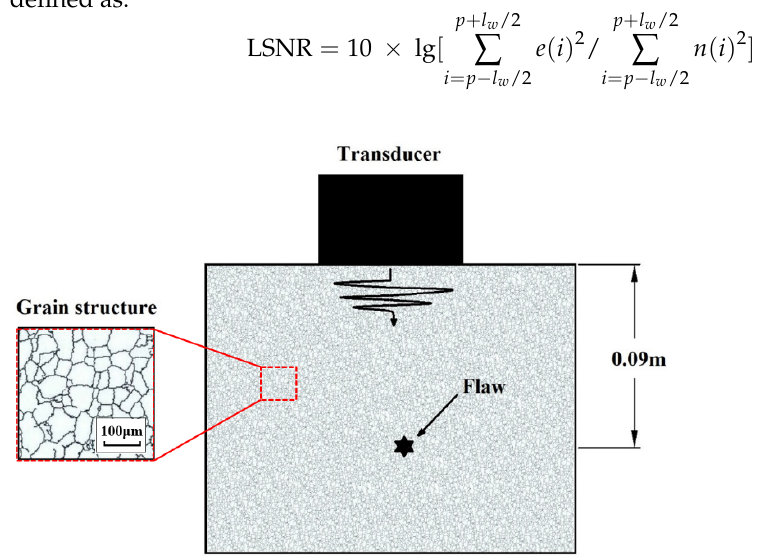
Figure 2. Schematic plot of the NDT scenario for simulation study.